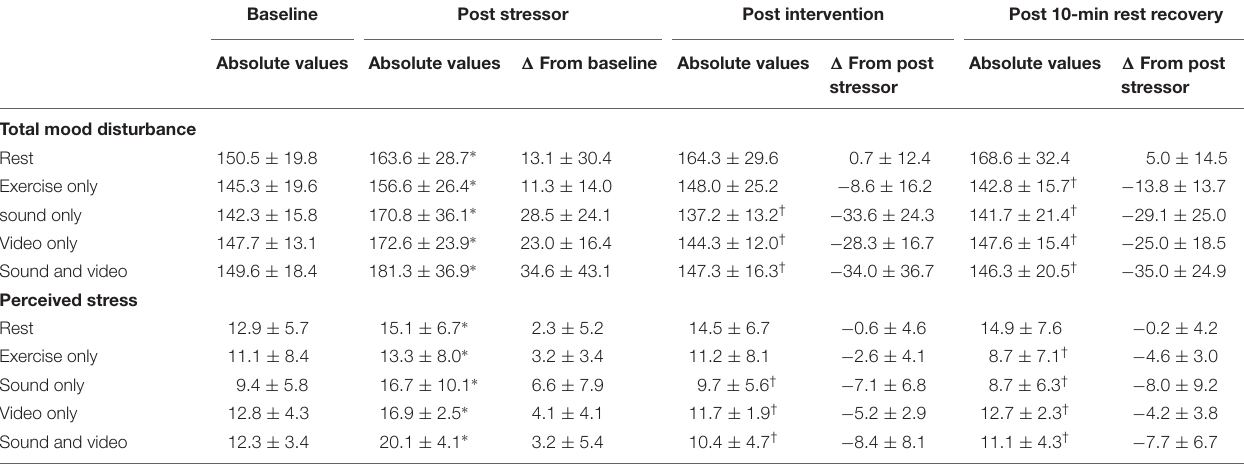
TABLE 1 | Changes in total mood disturbance and perceived stress following the strees induction task, 5 min recovery intervention and 10 min resting recovery. Baseline Post stressor Post intervention Post 10-min rest recovery Absolute values Absolute values (cid:49) From baseline Absolute values (cid:49) From post